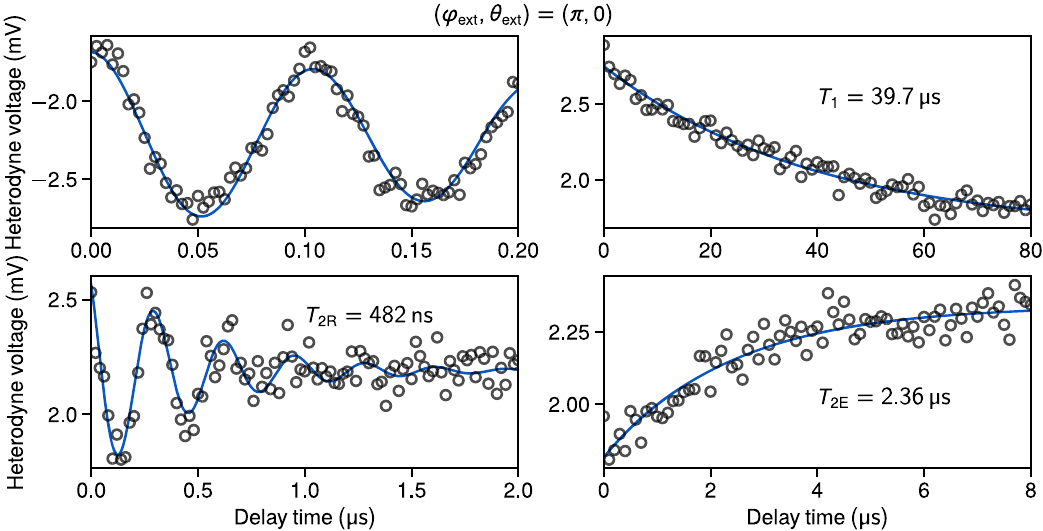
π ; 0 Þ . Clockwise from top left: Rabi ; θ ext ext Þ ¼ ð